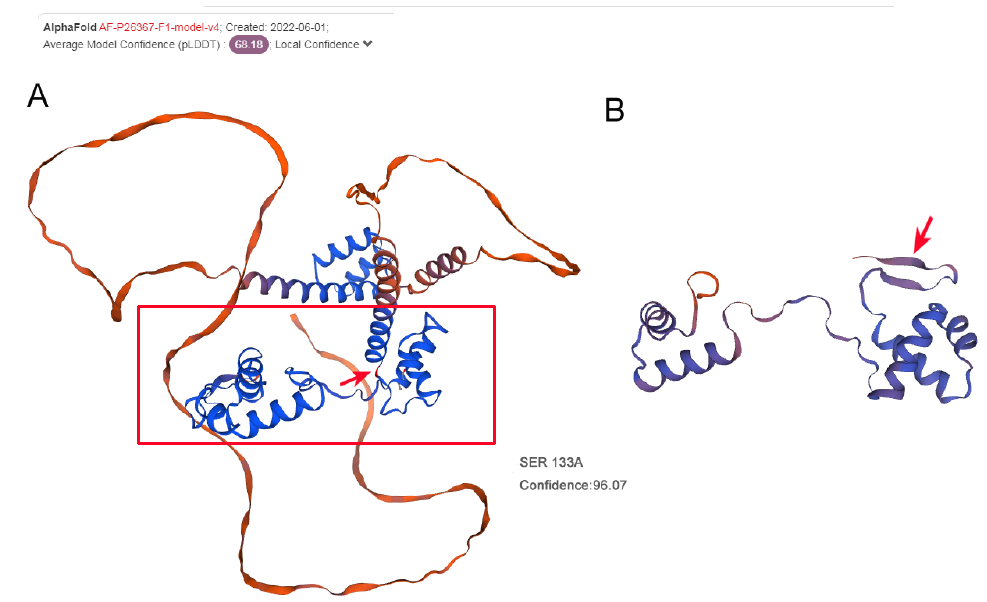
Figure 5. Three-dimensional structure prediction of wildtype PAX6 and mutated PAX6 protein. ( A ) Wildtype PAX6 structure. ( B ) Mutated PAX6 structure. The red arrow indicates the mutated position S133.